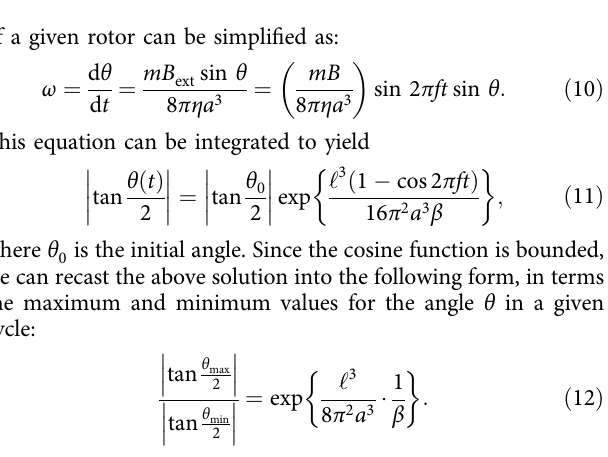
¼ 1 = π , while the horizontal c